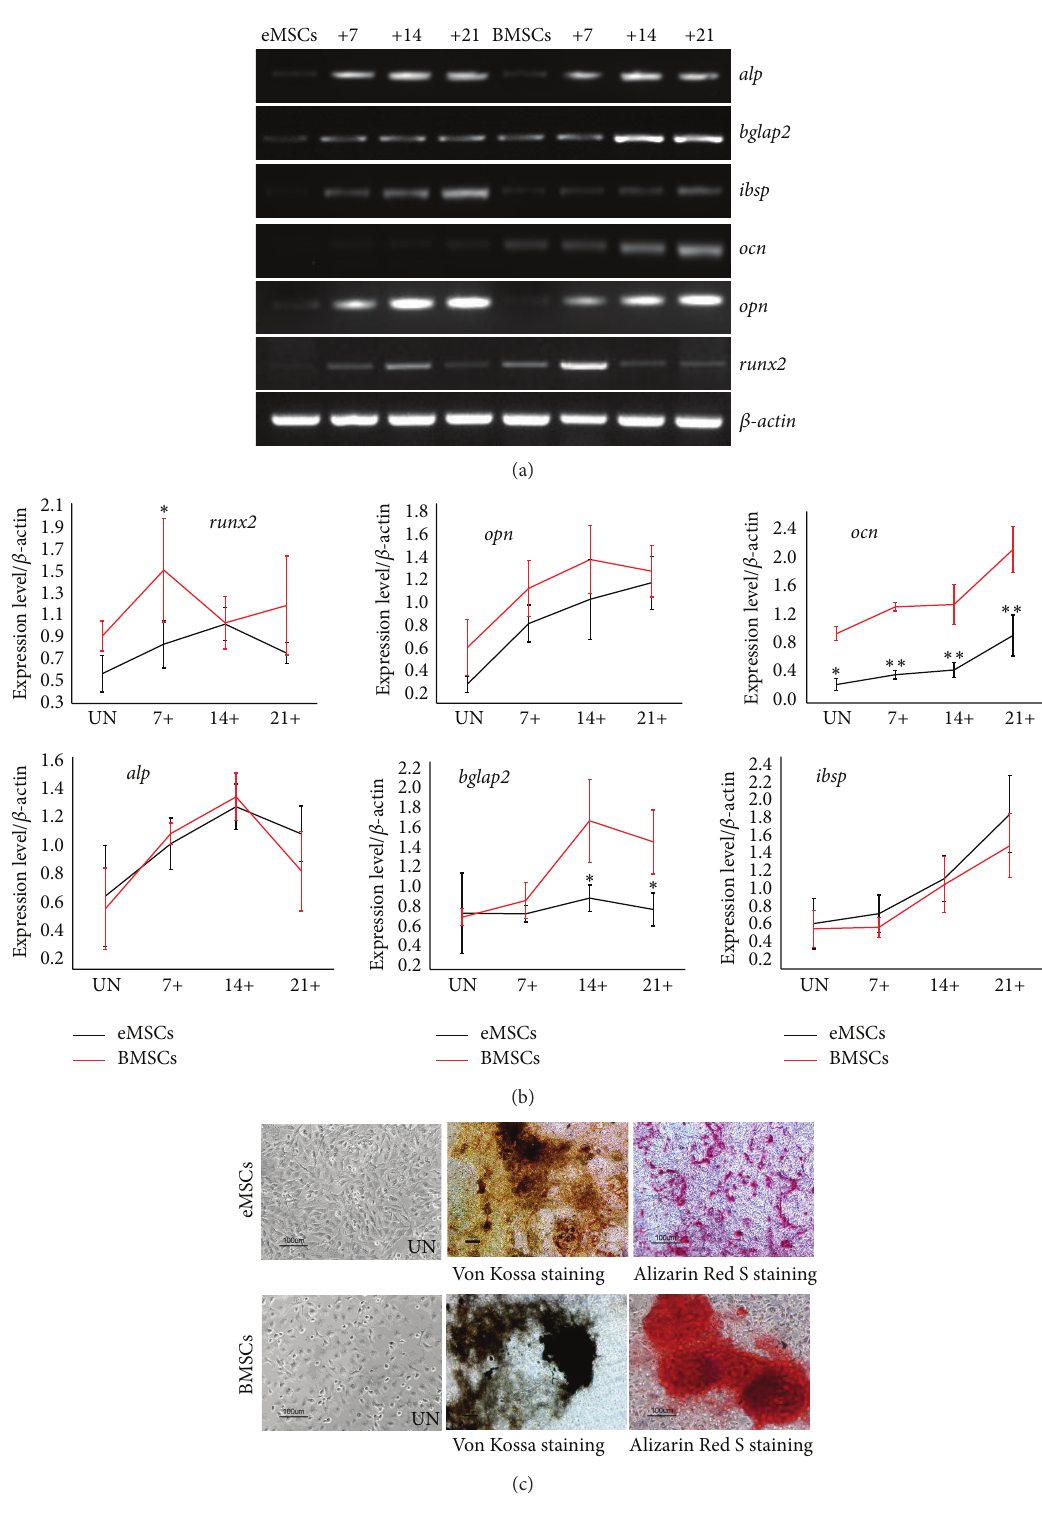
Figure 4: Osteogenic differentiation potential of eMSCs and BMSCs. (a) RT-PCR analysis of the gene expression profiles related to osteogenic differentiation. RNA samples from uninduced cells (UN) and induction cells (days +). (b) Semiquantitative analysis of gene expression levels by RT-PCR. RNA samples from uninduced cells (UN) and induction cells (days +). The relative expression of each gene was compared with the expression of 𝛽 -actin in the same sample. Values are the means ± SD from 3 independent experiments. ∗ 𝑃 < 0.05 , ∗∗ 𝑃 < 0.001 . (c) Von Kossa and Alizarin Red S staining 21d after osteogenic induction or uninduced cells